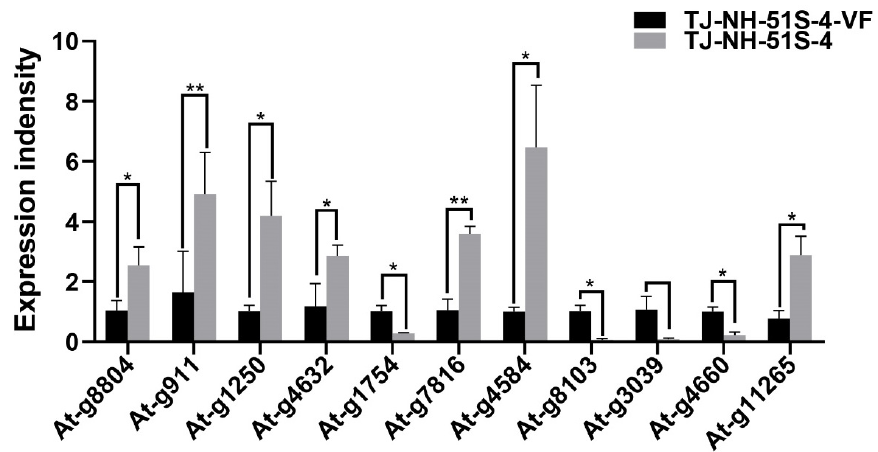
Figure 5. Validation of the RNA sequence (RNA-seq) data obtained for Alternaria tenuissima strains TJ-NH-51S-4 and TJ-NH-51S-4-VF using reverse transcription-quantitative polymerase chain reaction (RT-qPCR). Information on the eleven differentially expressed genes (DEGs) is provided in detail in Table S5. Stars indicate different levels of significant difference between the two strains as determined by paired t -test using Graphpad Prism version 8.0 software (*, p < 0.05; **, p < 0.01).